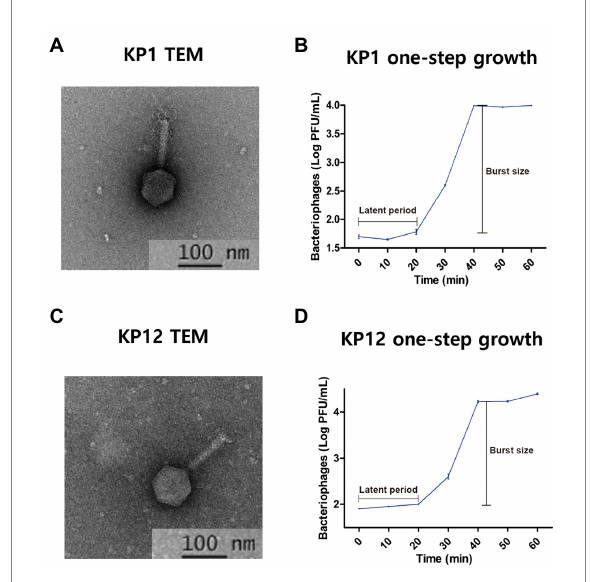
FIGURE 1 Isolated bacteriophages infecting Klebsiella pneumoniae KP1 and KP12. Transmission electron microphotographs (TEM) and one- step growth curves of KP1 (A,B) and KP12 (C,D) . The scale bars in each TEM represent 100 nm. TEMs indicate both phages show the classic form of Myoviridae with contractile tails (approximately 11 nm in diameter and 90 nm in length) and icosahedral heads (approximately 60 nm). The one-step growth curves for KP1 (B) and KP12 (D) show their latent periods estimated to be 20 min. The burst sizes of KP1 and KP12 were observed to be 197 and 312 PFU per infected cell,